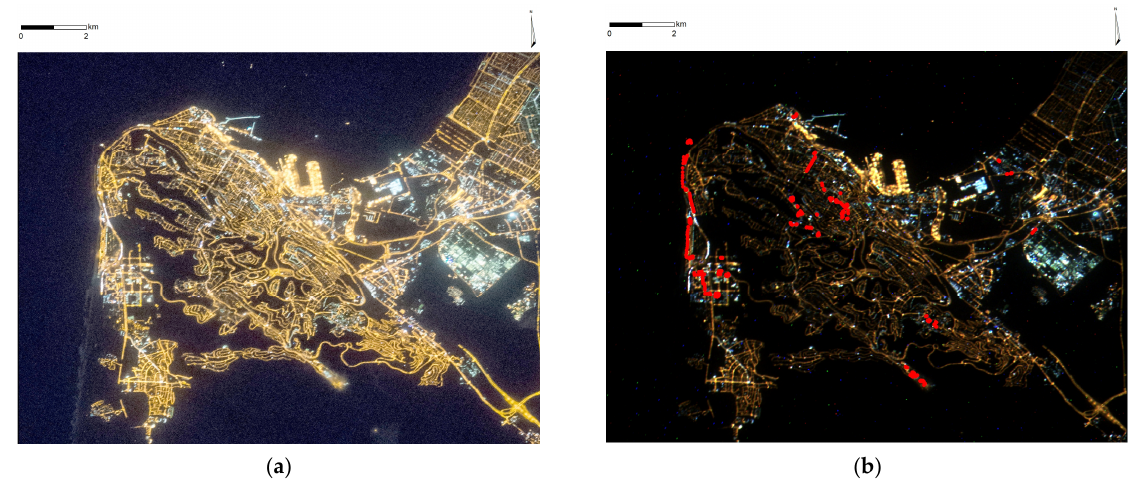
Figure 2. Georeferenced ISS-produced (taken on 29.11.2015 by Nikon D4 DSLR camera; ID ISS045-E-148262) ( a ) and radiometrically calibrated ( b ) night-time image of the Haifa region. In situ measurements (n = 610), performed in March 2015 via Konica Minolta CL-500A spectrometer, are marked by red dots in the right sub-figure.